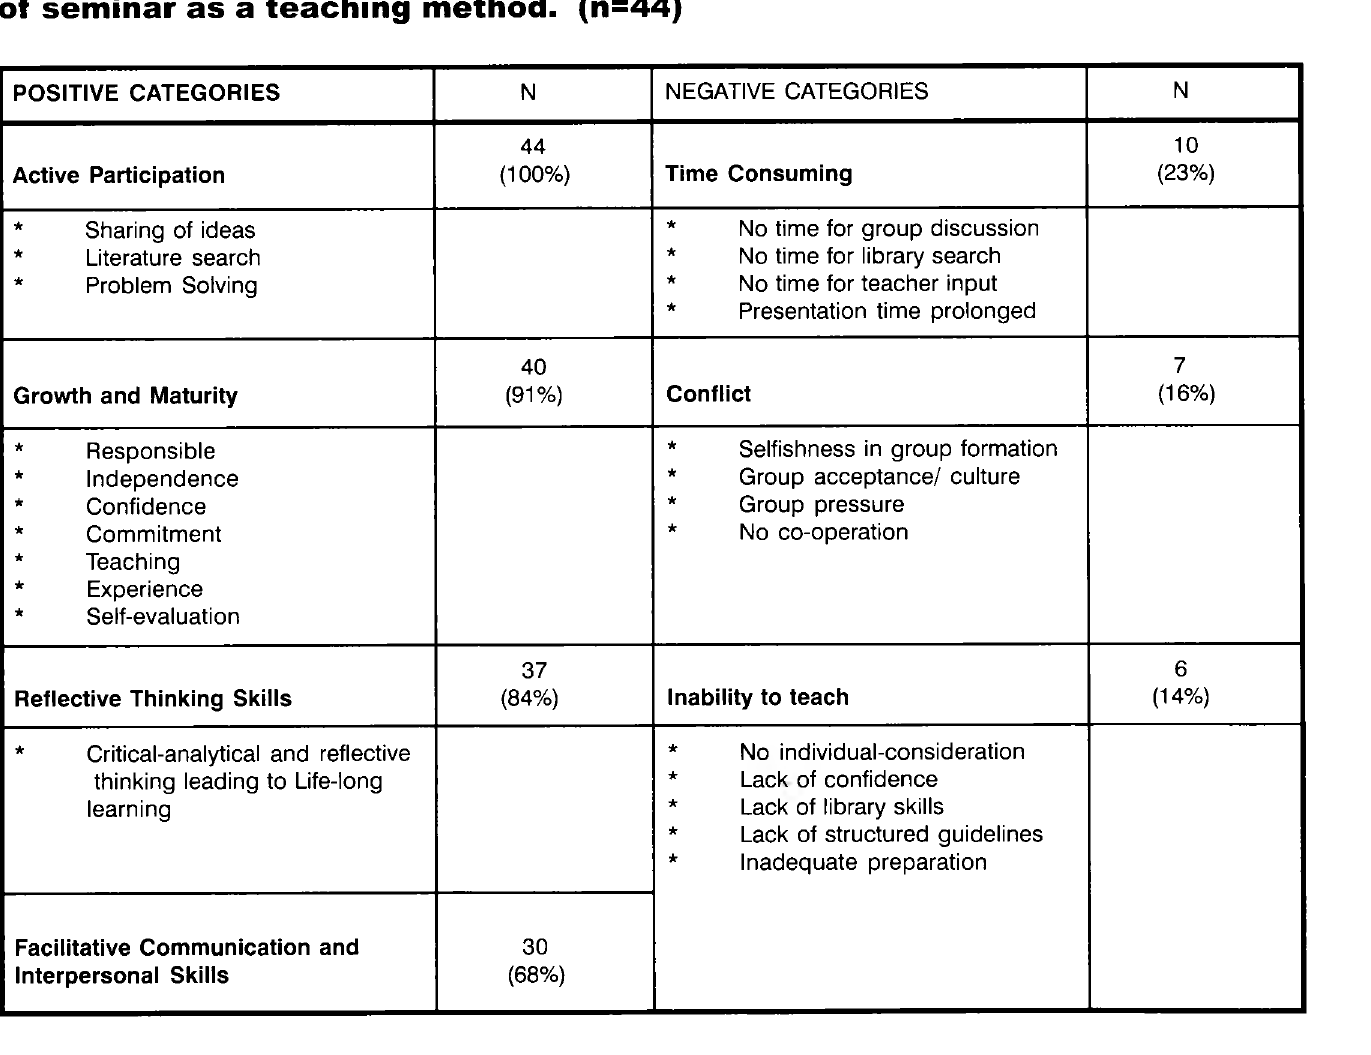
Table 1: Distribution of perceptions of post-basic nursing students in the use of sem inar as a teaching method.